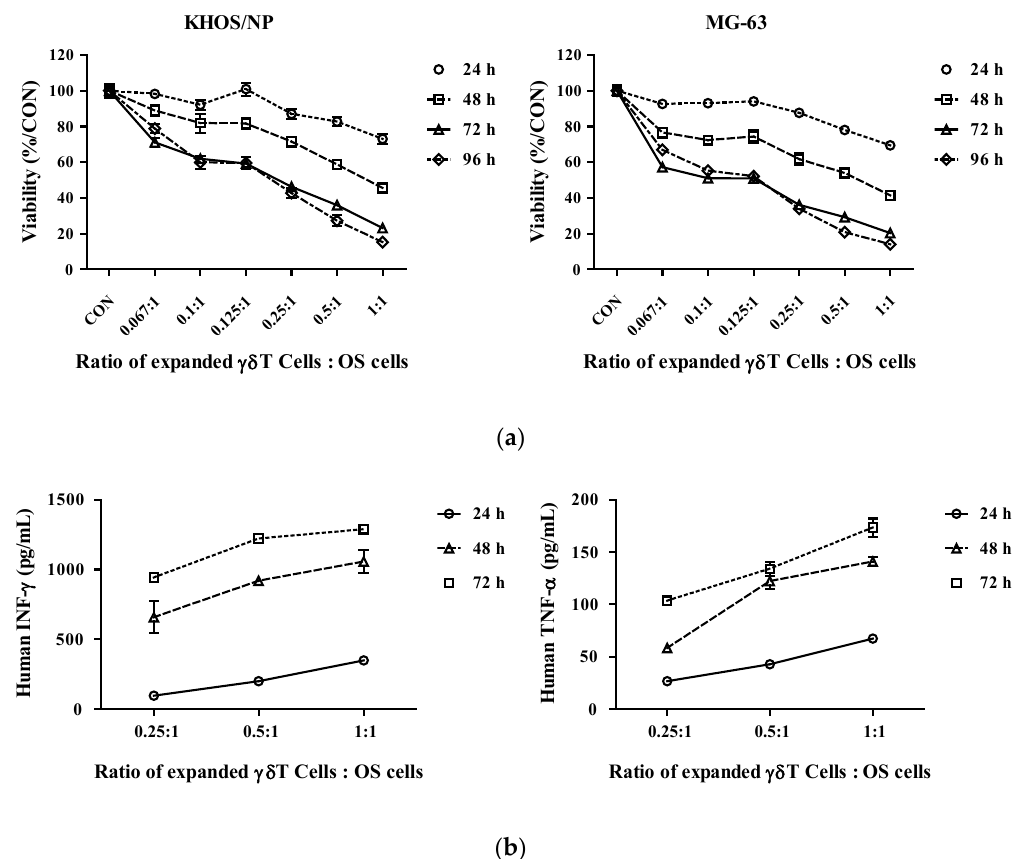
Figure 3. Cytotoxicity and cytokine production by expanded γδ T cells in osteosarcoma (OS) cells in vitro. The expanded γδ T cells were co-cultured with OS cells. ( a ) Cytotoxicity assays. After co-culture with OS cells, cytotoxicity and cell viability were measured using the EZ-CyTox cell viability assay kit after 24, 48, 72, and 96 h. ( b ) ELISA for cytokine production. After co-culture with KHPS/NP cells, the supernatant concentrations of both IFN- γ and TNF- α were measured using an ELISA kit. The percentages are represented as the mean ± SEM.